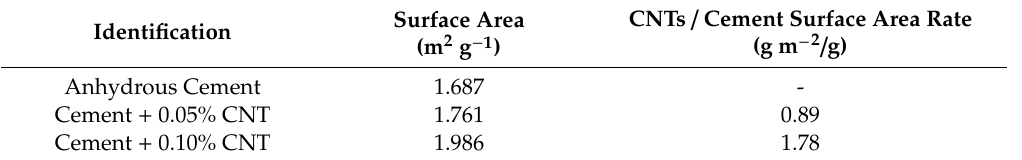
Table 2. Surface area obtained by nitrogen adsorption.